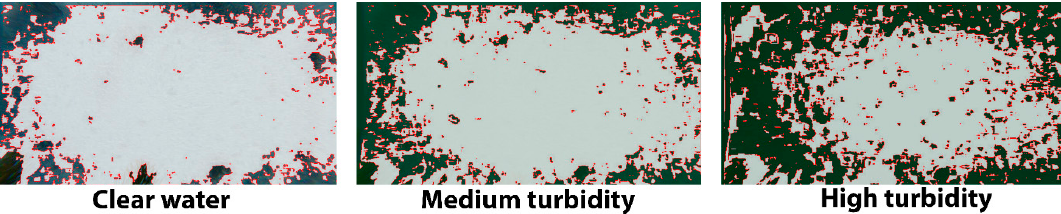
Figure 16. Detected corroded regions (unfaded pixels) of a corrosion stain under each turbidity level for a texture analysis-based image processing technique.